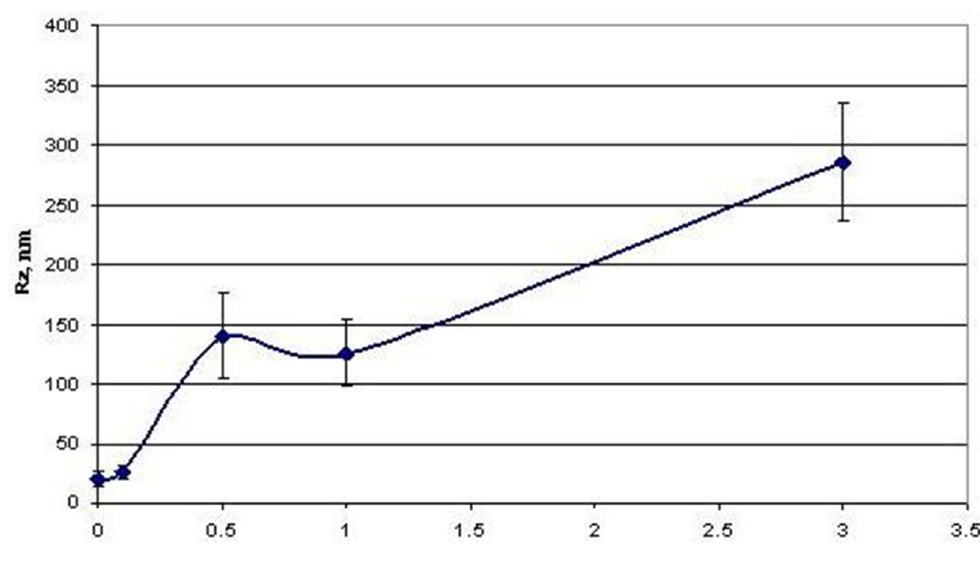
Figure 5. Dependence of the maximum height difference (R Z ) on the surface of the composite films on SWCNT concentration.